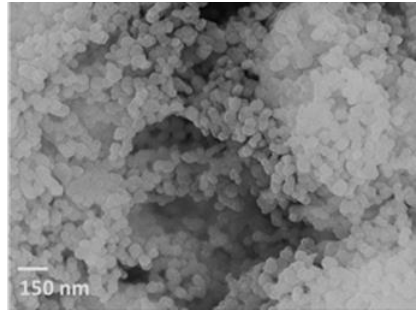
Figure 9. SEM images of Ca 0.97 Mg 0.025 Al 0.005 -MOF-O powder subjected to multiple carbonation- calcination for 100 cycles.